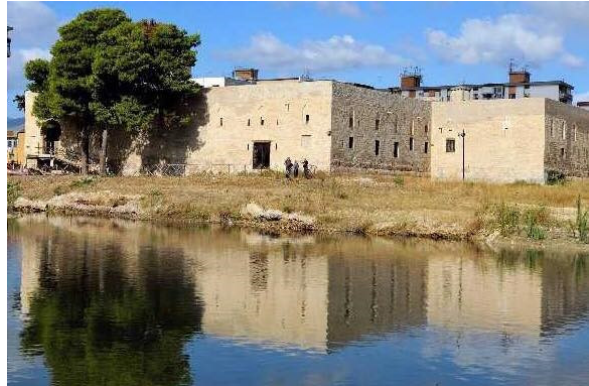
Figure 2. The artificial water basin in the park of the Castle of